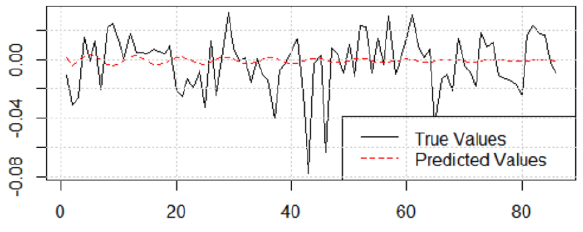
Figure 8: ACF plot of the residuals of the model selected by AIC